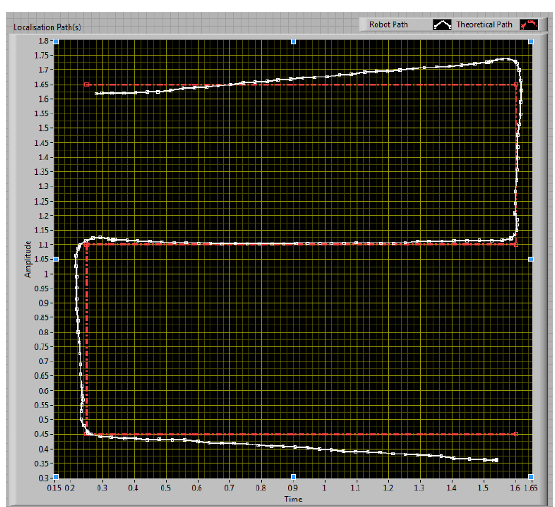
Figure 14. Actual (white) vs. Required trajectory (red) following us- ing Video Tracking